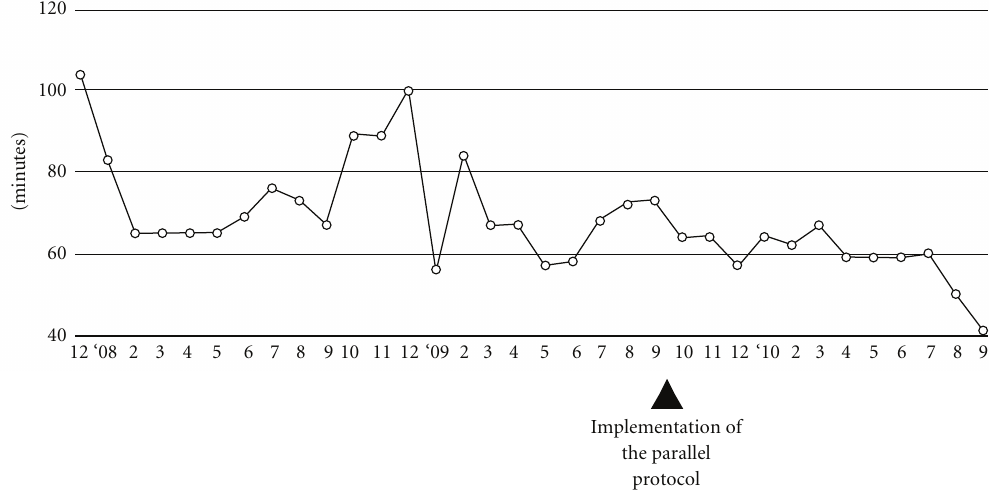
Figure 3: Time series of the three-month running median of door-to-needle